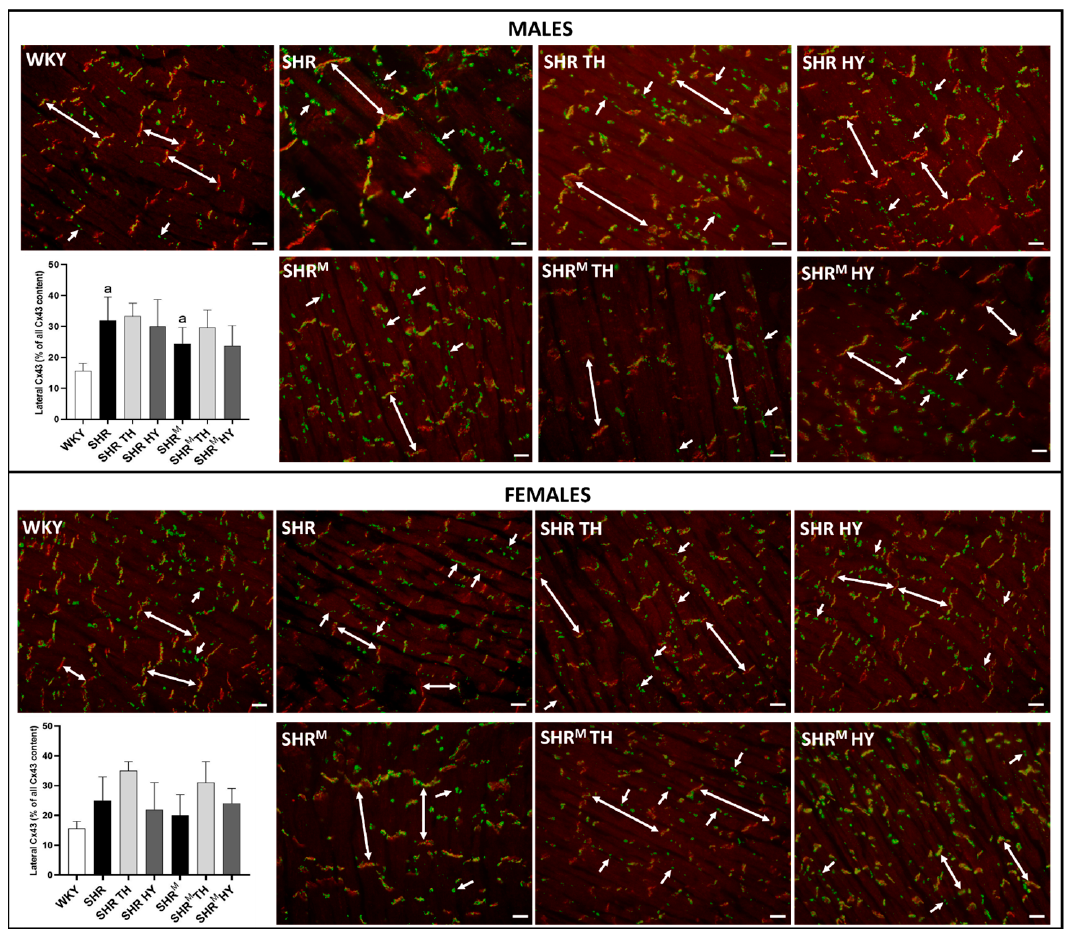
Figure 7. Detection of the myocardial topology of Cx43 using immunofluorescence labeling. Double arrows represent the colocalization of Cx43 (green) with cadherin (red) at the intercalated discs of the cardiomyocytes, and simple arrows show Cx43 localization on the lateral sides of the cardiomyocytes. The graphs represent the quantification of lateral Cx43. Note the abnormal lateral localization is suppressed in male SHR M compared to SHR. WKY—Wistar Kyoto normotensive control rats, SHR—wild type spontaneously hypertensive rats, TH—hyperthyroid rats, HY— hypothyroid rats and SHR M —hairless spontaneously hypertensive rats, n = 5 per group. Scale bar represents 400 μ m. Data are presented as means ± SD, a p < 0.05 vs. WKY. One-way ANOVA and Bonferroni’s multiple comparison test were used as the statistical method.